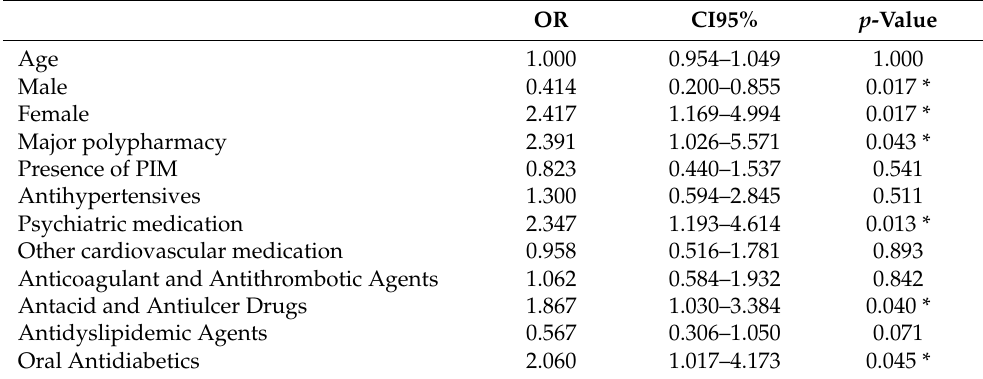
Table 4. Binary logistic regression analysis of potential association between cognitive impairment (MMSE scores) and the factors age, gender, major polypharmacy, PIM and various pharmacological classes in institutionalized older